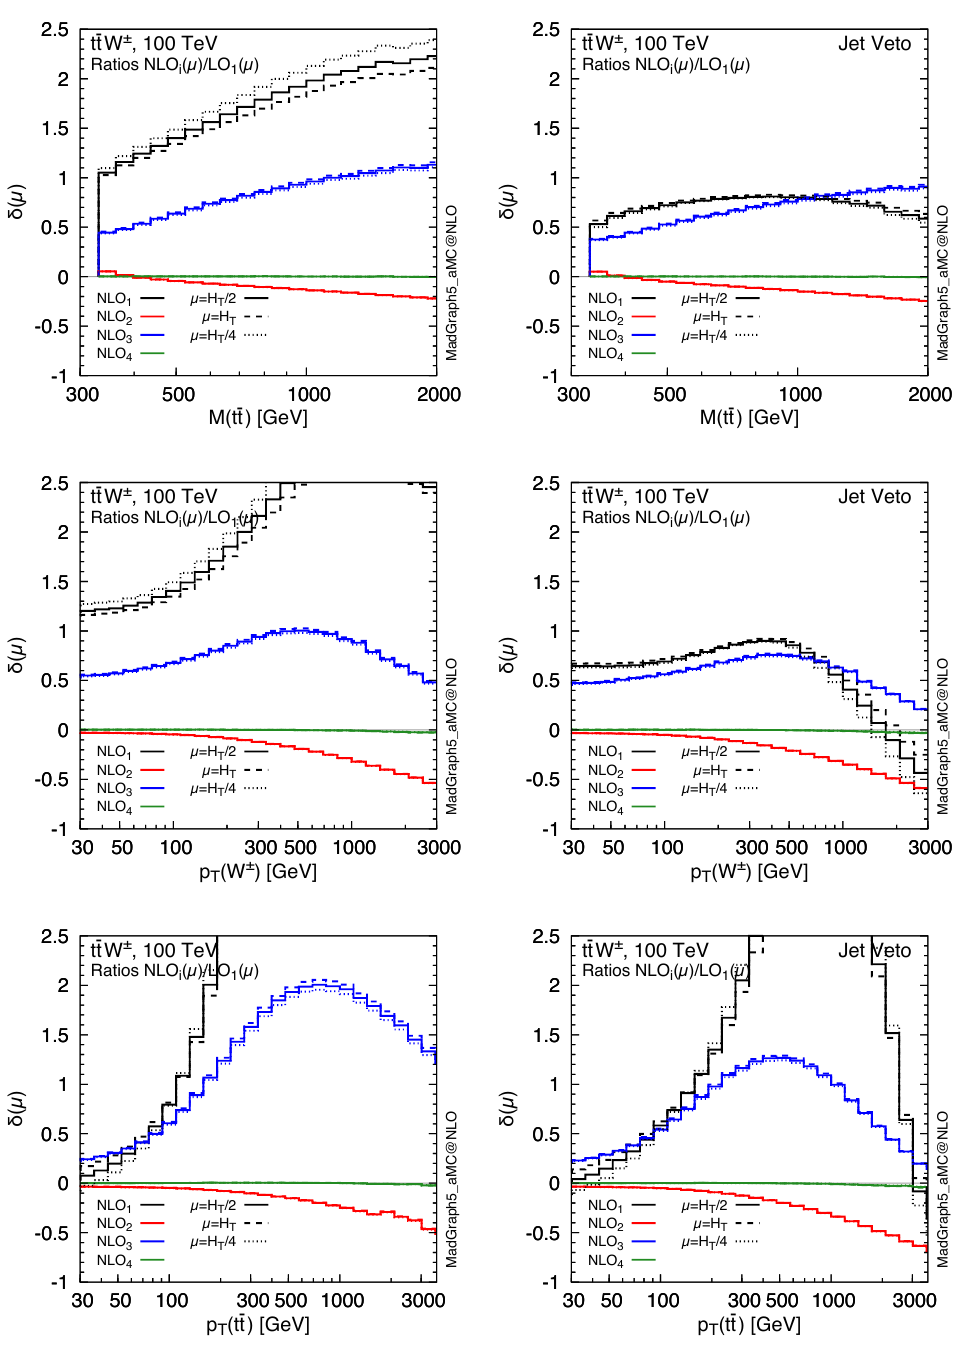
Figure 8 . Same as (cid:12)gure 7 but for 100 TeV collisions.